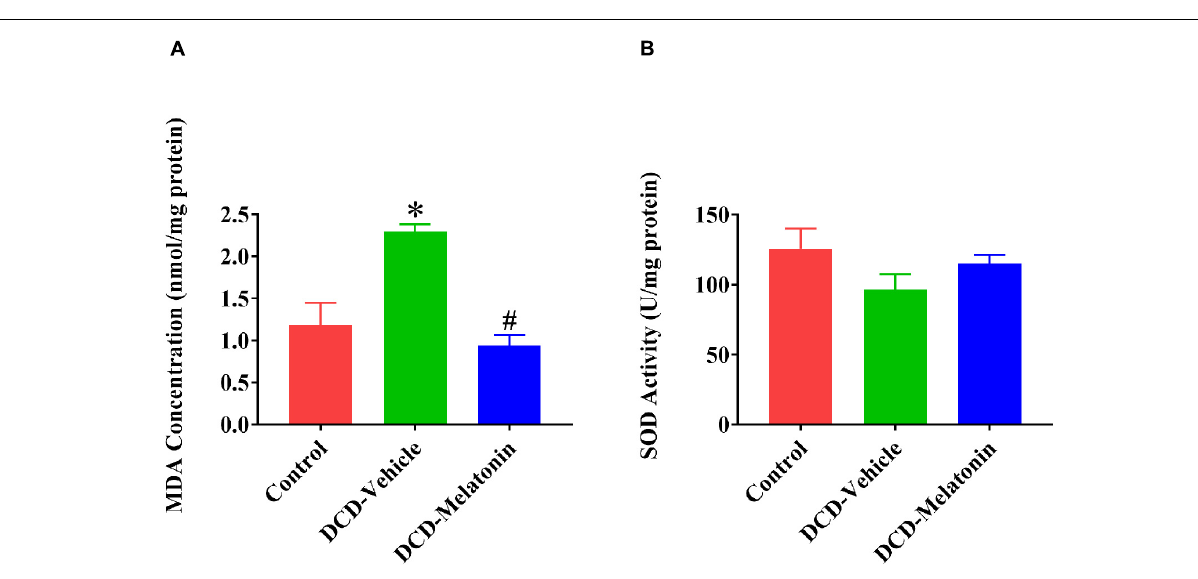
Frontiers in Cell and Developmental Biology |